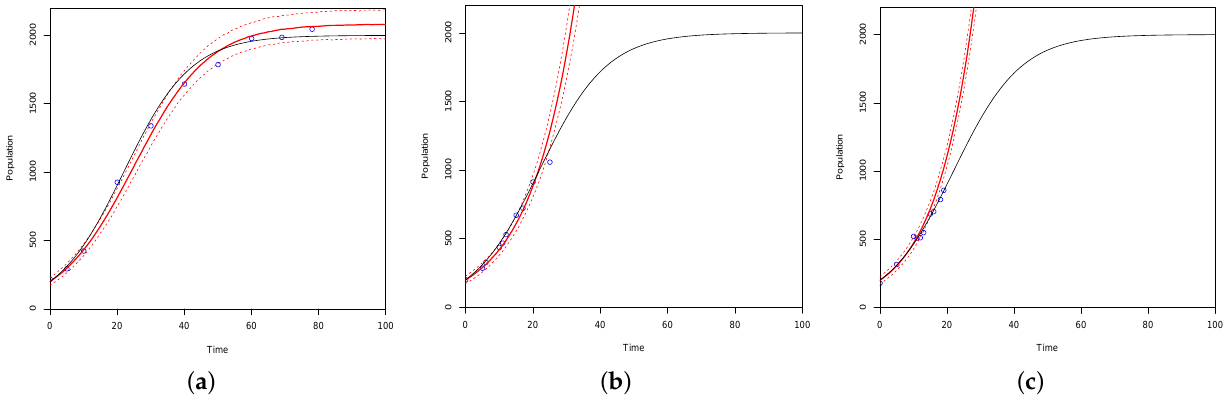
Figure 12. 10,000 MCMC samples simulate a normal growth curve increasing at a 10% rate across 100 time points with a carrying capacity of 2000. Sequential optimality is used with the Bayesian design criteria to find the ten best points for ( a ) ¯ U I , ( b ) ¯ U A and ( c ) ¯ U D optimal designs. The optimal points are plotted in blue and fit with a solid red curve. The red dotted lines represent the 2.5% and 97.5% quantiles of the predicted values of the model. The black curve represents the ground truth